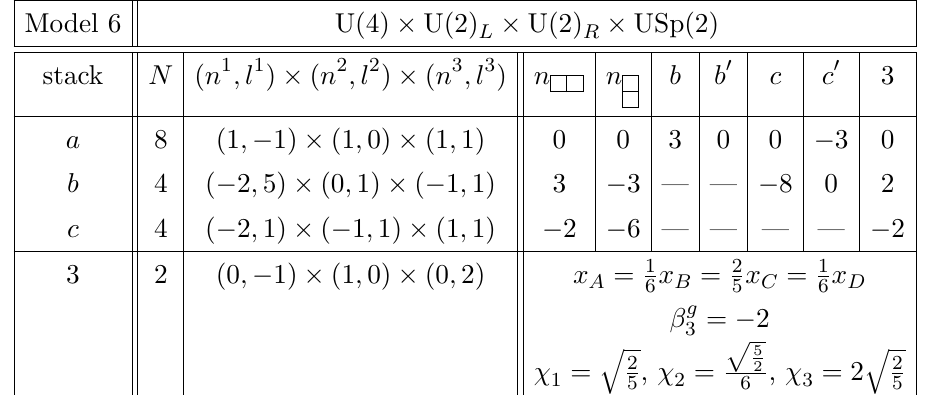
Table 13 . D6-brane configurations and intersection numbers of Model 6, and its MSSM gauge